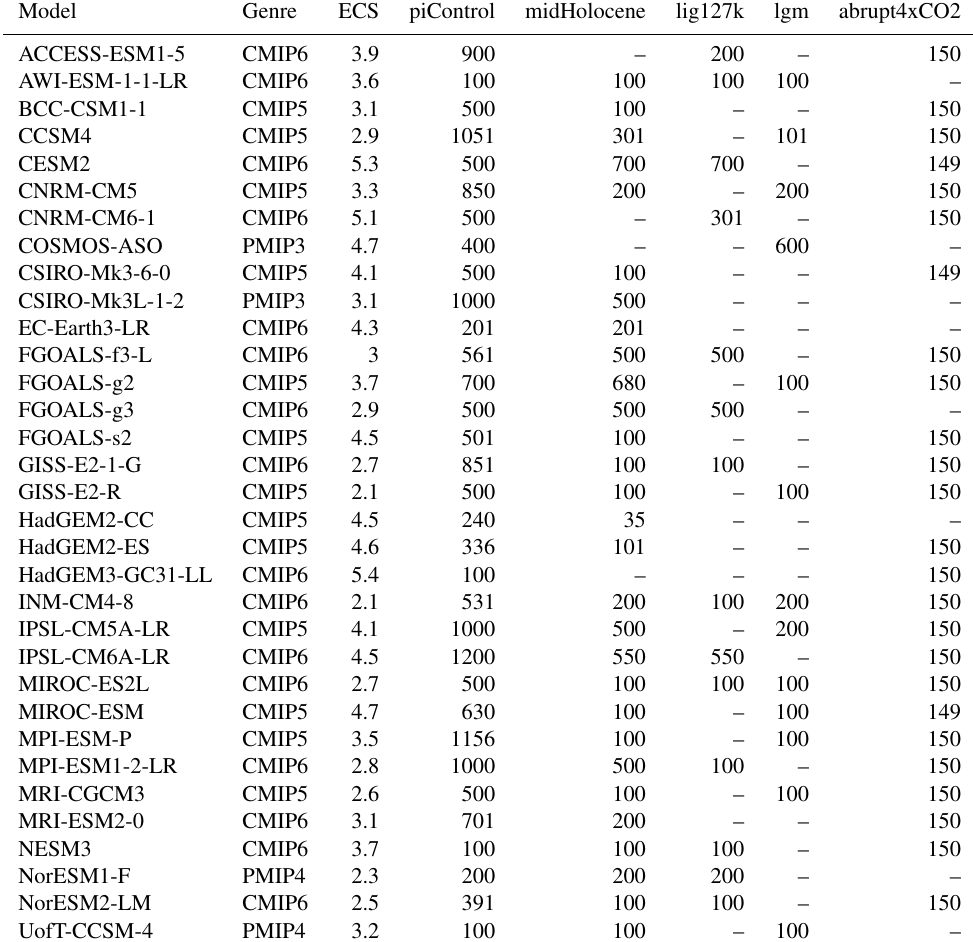
Table 1. The ensembles analysed in this work. For each of the models, we provide the amount of simulation output analysed for each experiment (in years). Not all models performed all experiments. The “genre” shows whether a model produced future simulations as part of either CMIP5 or CMIP6 or only performed the palaeoclimate experiments (PMIP3 or PMIP4). Also shown is the equilibrium climate sensitivity (ECS, in ◦ C) from either Collins et al. (2013); Zelinka et al. (2020) or the article introducing the